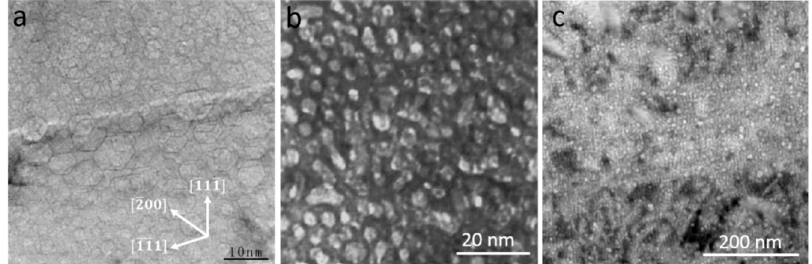
Figure 1. Dense He bubbles after He irradiation in: ( a ) Al [10]; ( b ) tungsten [11]; and ( c ) Zr [12].